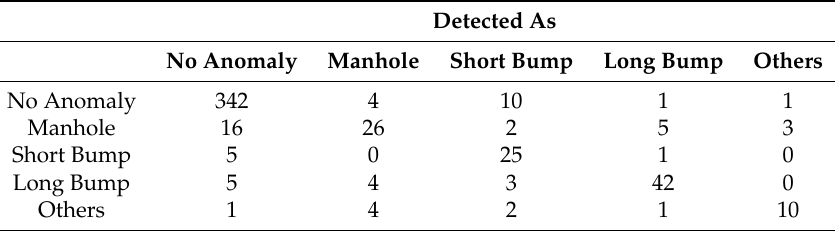
Table 3. Confusion Matrix for “Condtitioned” Setup.